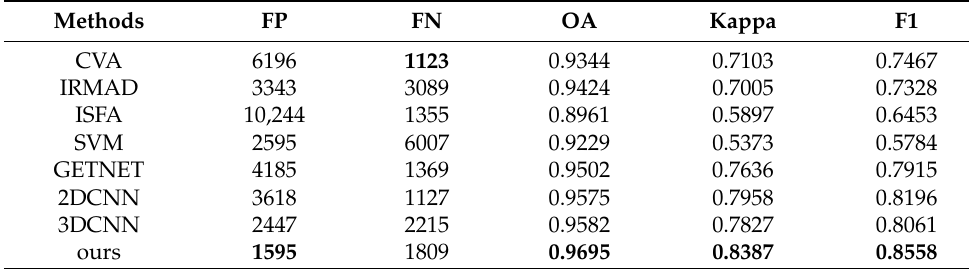
Figure 9. The change map on River dataset. ( a ) CVA. ( b ) IRMAD. ( c ) ISFA. ( d ) SVM. ( e ) GETNET. ( f ) 2DCNN. ( g ) 3DCNN. ( h ) ours. Table 4. Quantitative evaluation of CD results by different methods for River